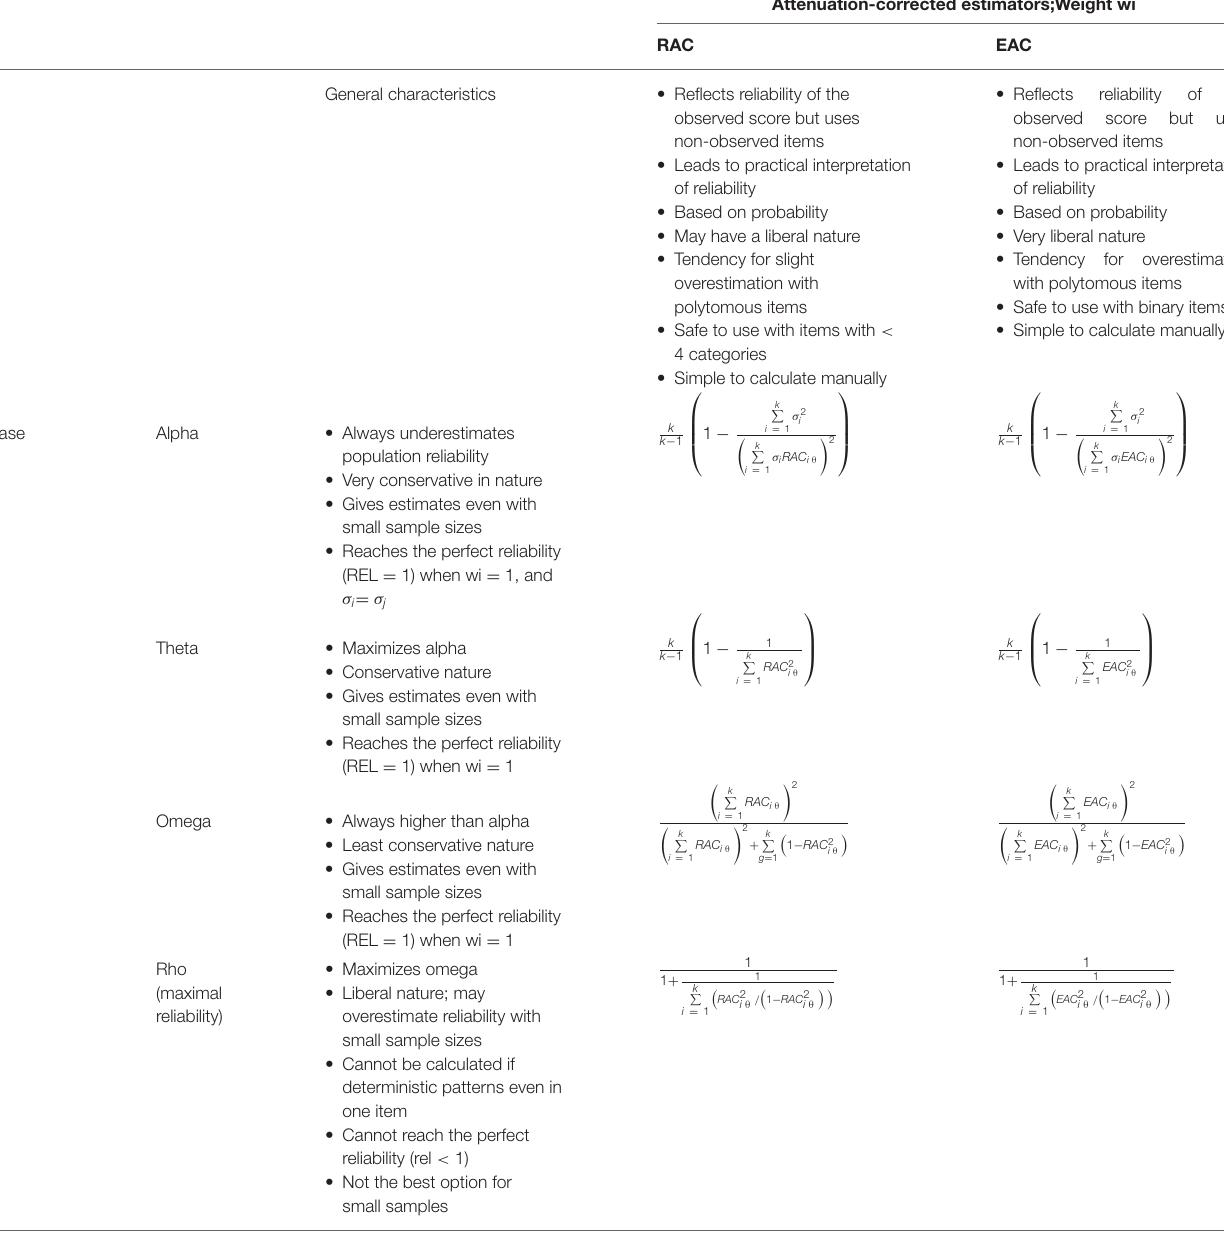
TABLE 2b | Typology of selected deflation-corrected estimators of reliability and their characteristics; attenuation-corrected